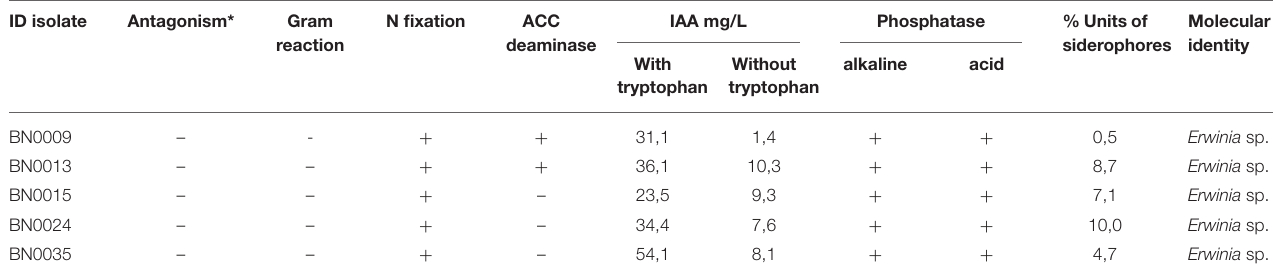
TABLE 2 | Different PGPR traits and molecular identity of the 5 reported isolates (*Antagonism against Sclerotina sp. and Botrytis sp.). ID